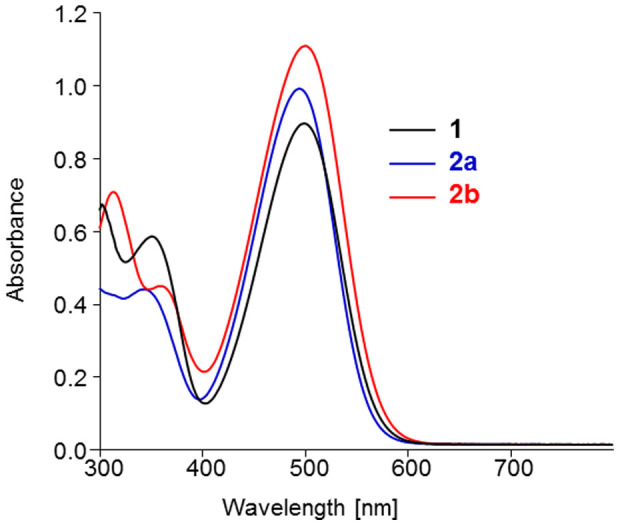
UV-Vis absorption spectra of compounds 1, 2a and 2b in CH2Cl2.The spectra of 3ab and 4bb have been omitted for clarity (see SI).